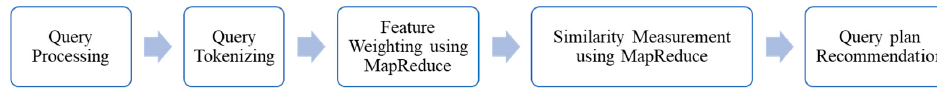
Figure 3. The map-reduce-based access plan recommendation.